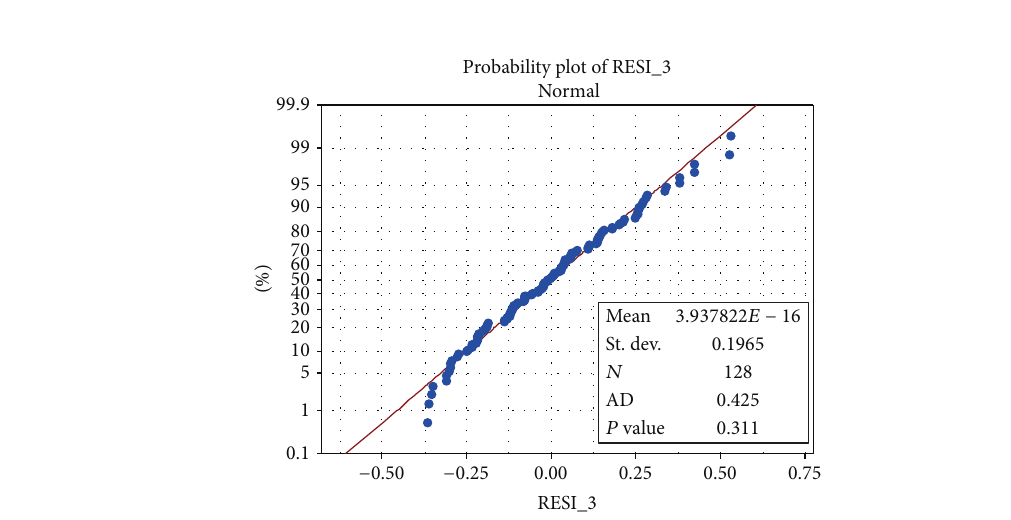
Figure 11: Residual plots for the response 𝑅 𝑡 .